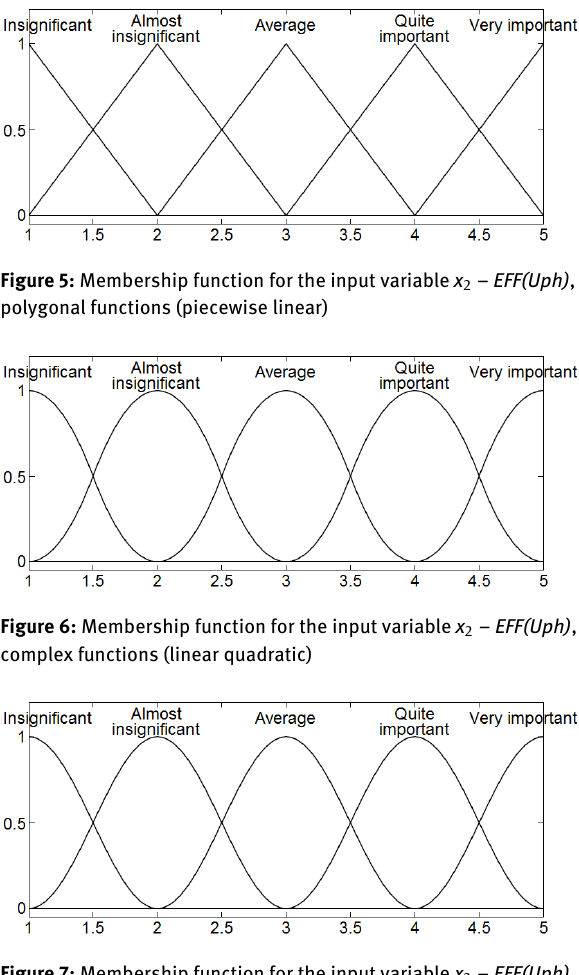
Figure 7: Membership function for the input variable x 2 – EFF(Uph)